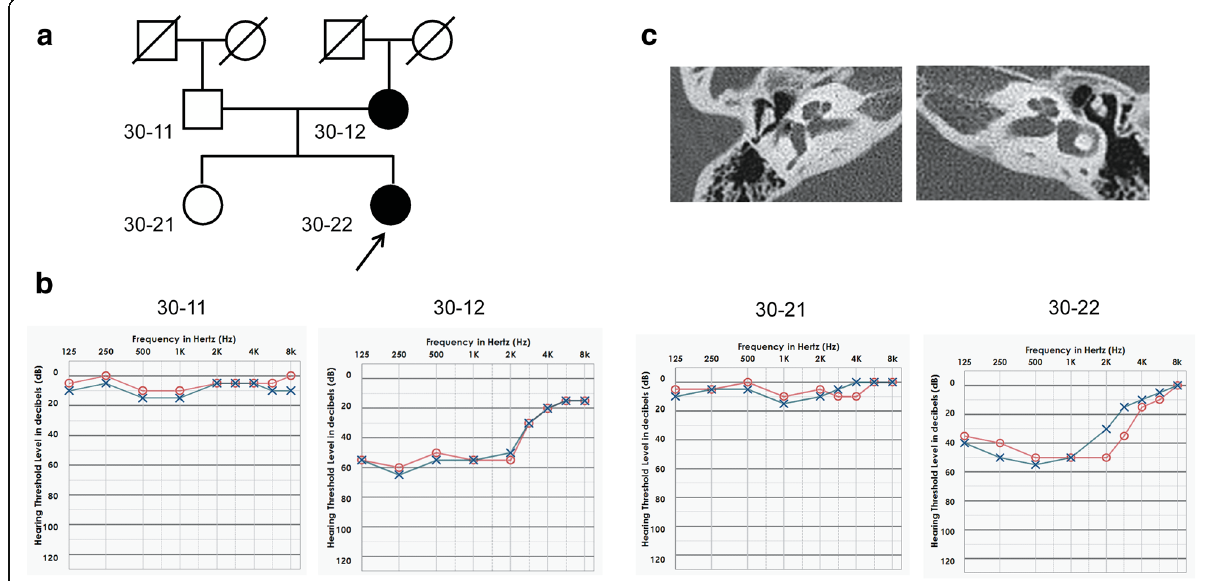
Fig. 1 Pedigree and audiological evaluation. a Pedigree of the family (Yonsei University Hearing Loss [YUHL] 30 family) is shown. Affected individuals are denoted by gray symbols, males are denoted by squares, and females are denoted by circles. The affected proband (30 – 22) was a 14-year-old fe- male with low-to-mid frequency nonsyndromic hearing loss. b Pure-tone audiometry of the subjects is depicted. Frequencies (Hz) were plotted on the x-axis and the auditory threshold in decibels (dB HL) was plotted on the y-axis. Red circles refer to the right ear, and blue crosses refer to the left